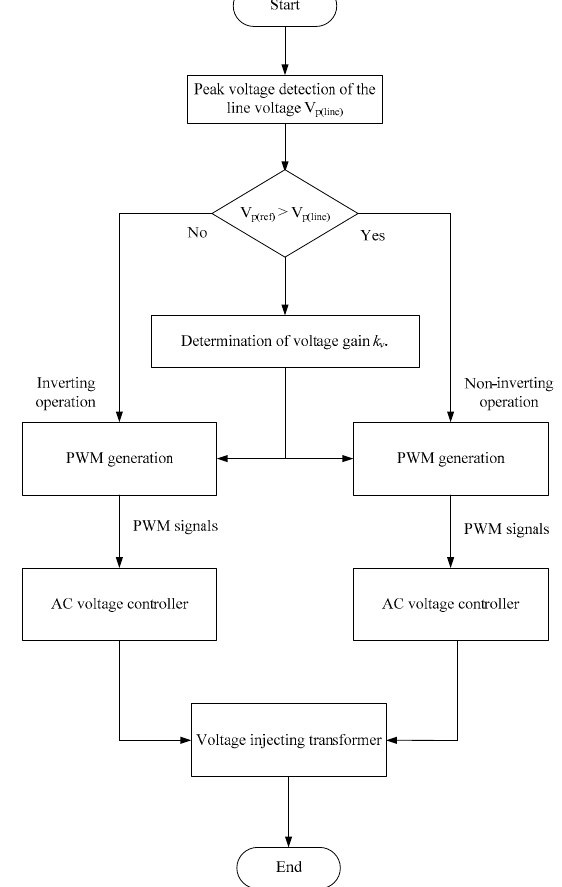
Figure 12. Flow chart of voltage correcting system.